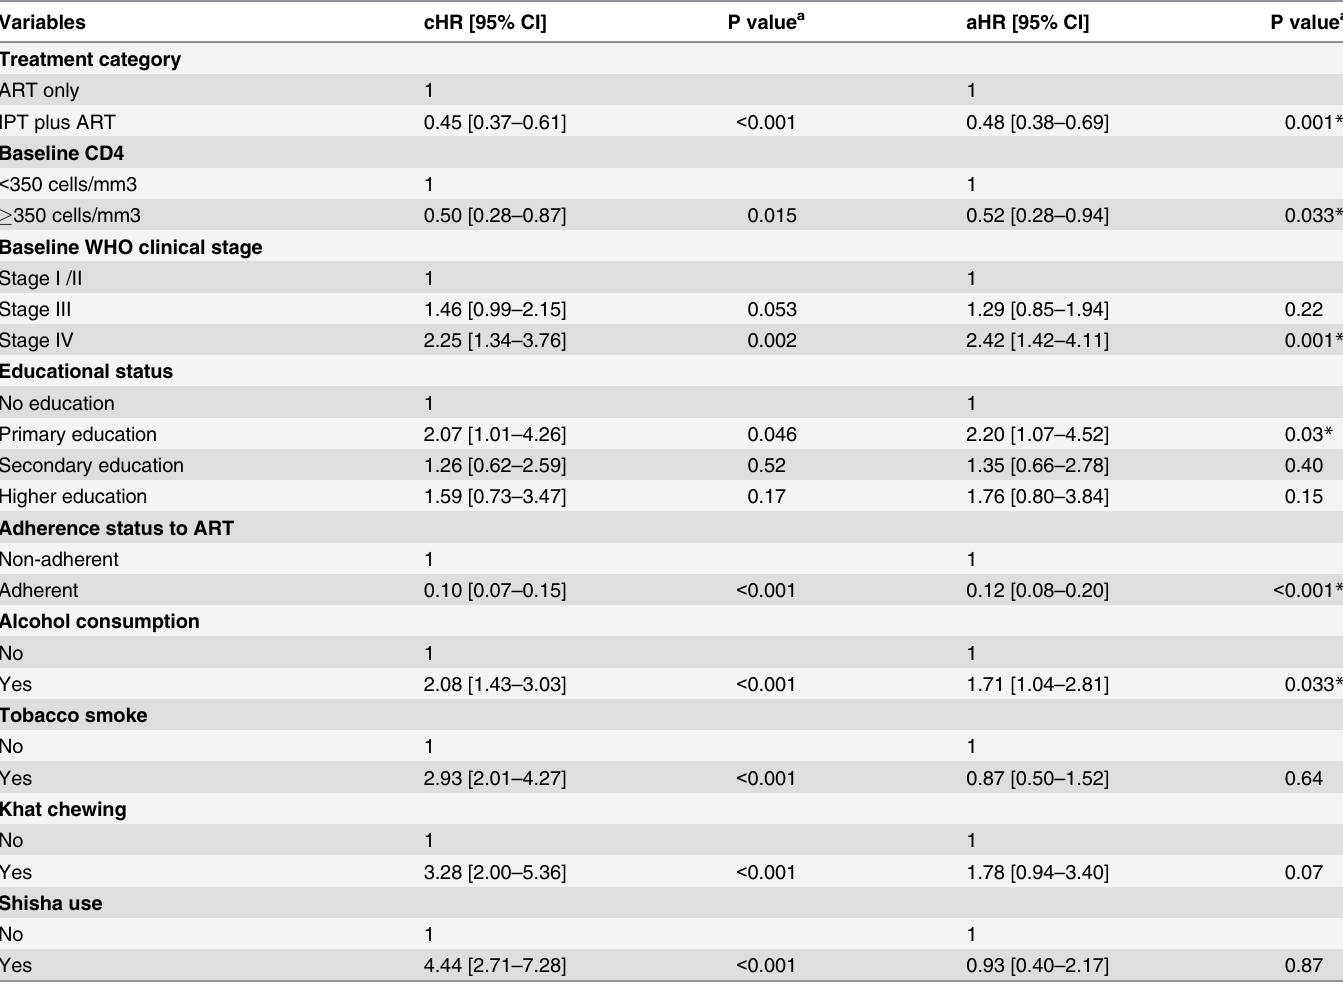
Table 2. Cox regression analysis for associations of all-cause mortality adjusted for covariates, Addis Ababa (N =